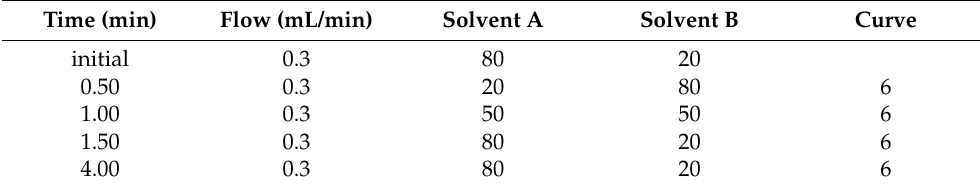
Table 1. Optimized UPLC-MS/MS parameters for LEM and IS.